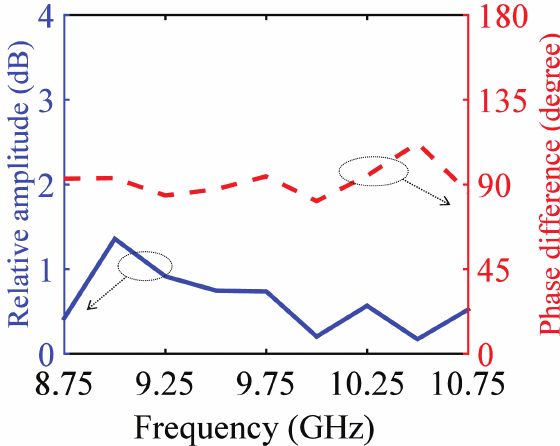
Figure 8: Amplitude and phase difference of horizontal po- larization component relative to the vertical polarization as a function of frequency for ϕ = 0 cut.